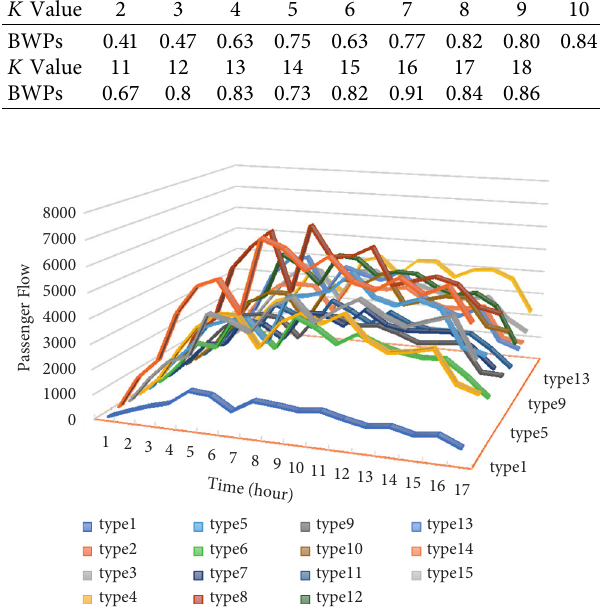
Figure 2: Passenger flow